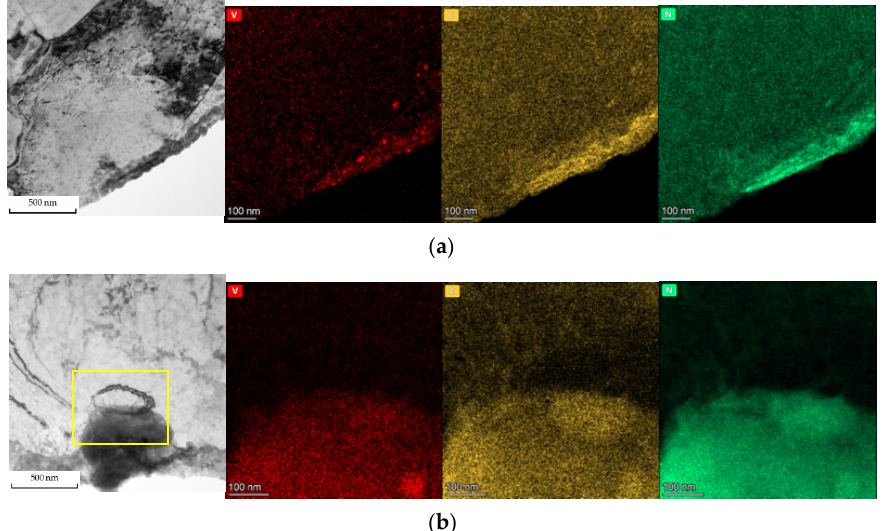
Figure 14. V(C, N) precipitates in the welding thermal simulation samples of the 10 V steel: ( a ) distribution and EDS analysis of precipitates in GRHAZ; and ( b ) distribution and EDS analysis of precipitates in